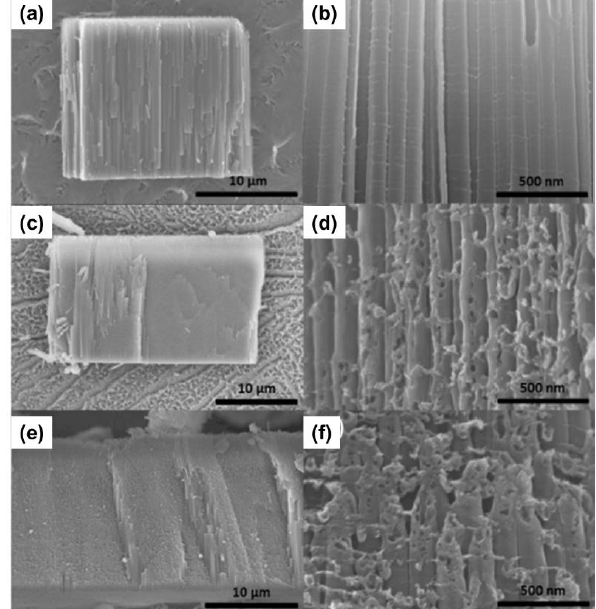
Figure 6. Representative cross-sectional SEM images of ( a , b ) regular and ( c – f ) irregular nanotubes formed by the anodization of Ti alloys. The nanotubes were formed by the anodization of Ti alloys containing ( a , b ) 0.02 at.%, ( c , d ) 0.05 at.%, and ( e , f ) 0.2 at.% of Ru. Reproduced with permission from